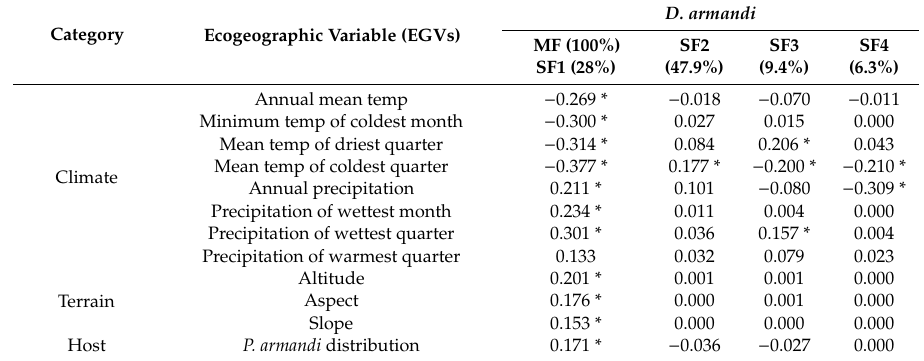
Figure 6. Potential distribution of D. armandi in China modeled with MaxEnt. Table 7. The first four factors and coe ffi cients of Ecogeographic Variables (EGVs) to factors generated by Ecological Niche Factor Analysis Table 8. Percentage of estimated contribution for EGVs by using MaxEnt.